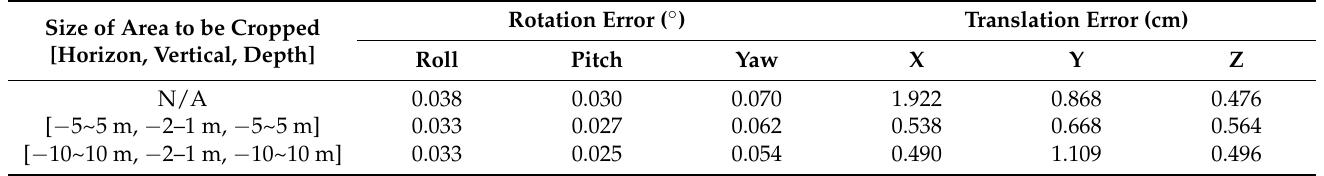
Table 5. Comparison of calibration performance according to the cropped area on the Oxford dataset.